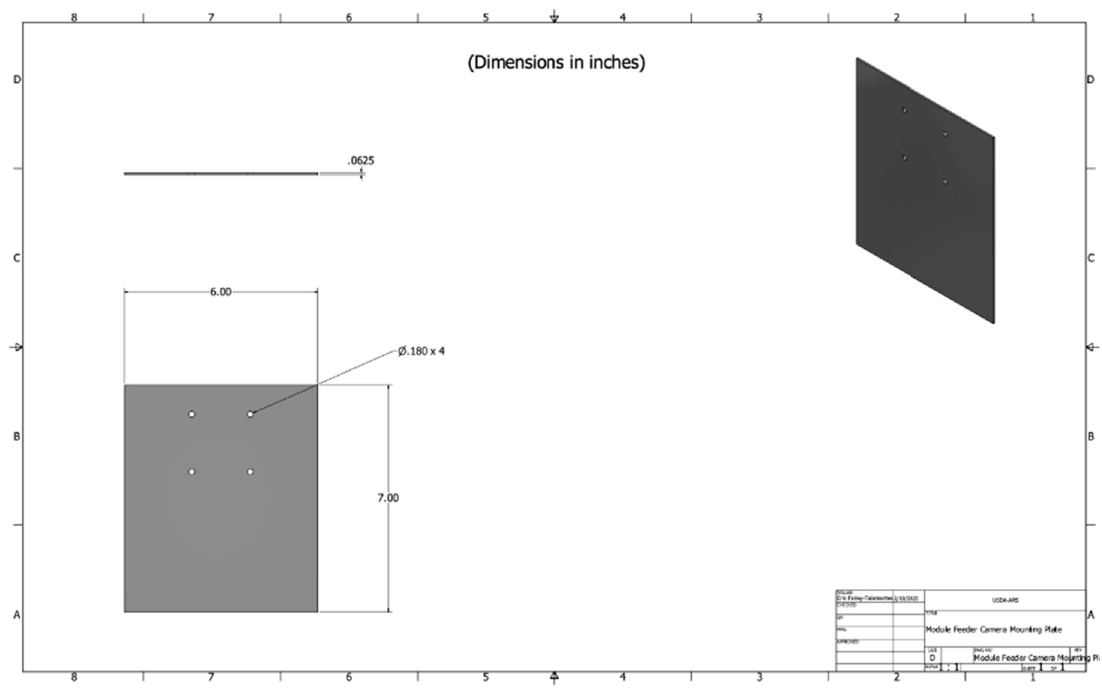
Figure 14. Module feeder camera mounting plate (#8 of assembly drawing).